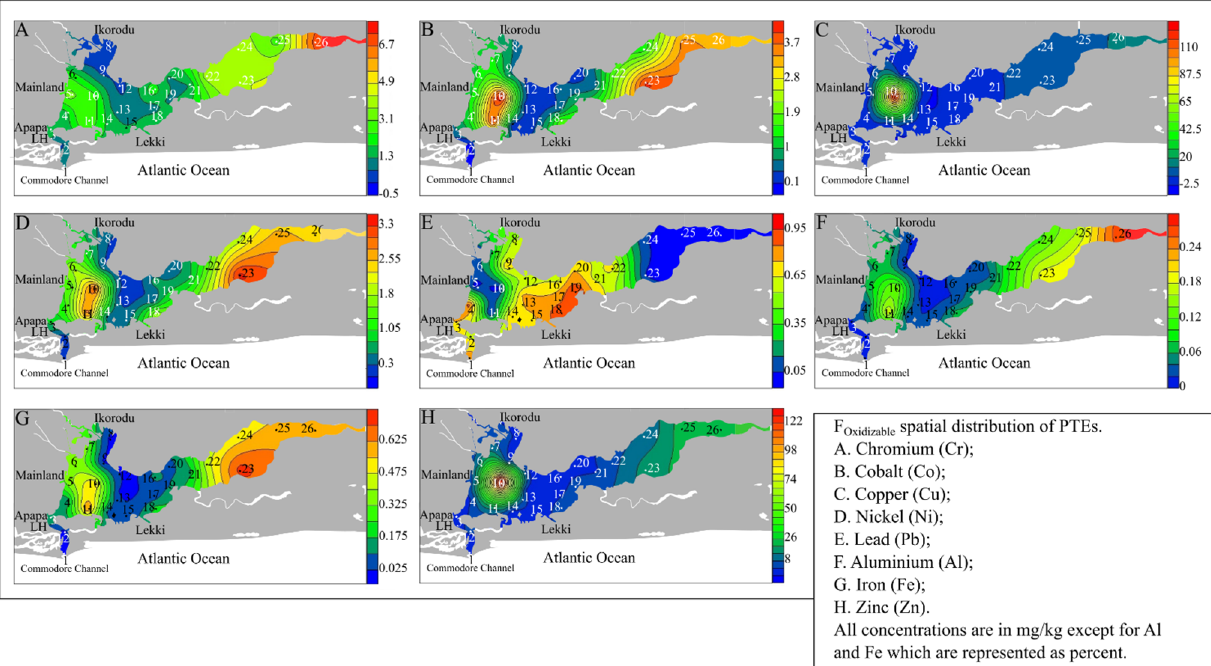
Figure A4. Oxidizable fractions heat maps.